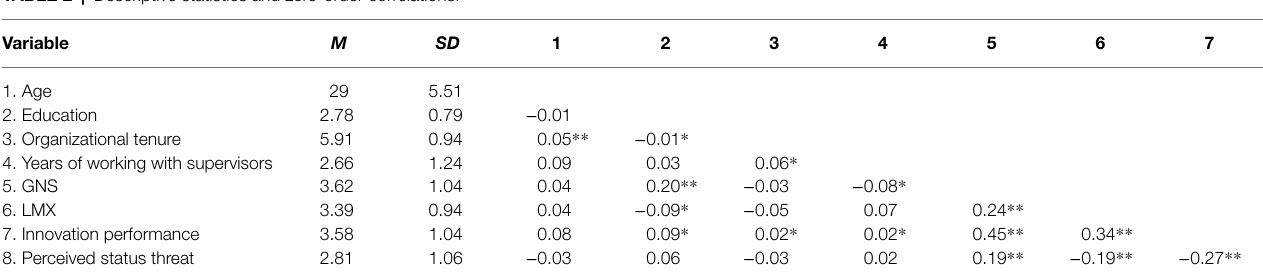
TABLE 2 | Descriptive statistics and zero-order correlations.